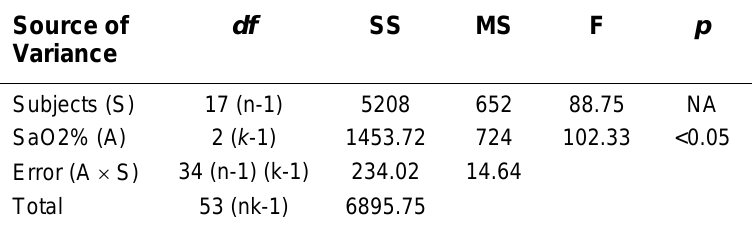
Summary for Single-Factor Repeated Measures